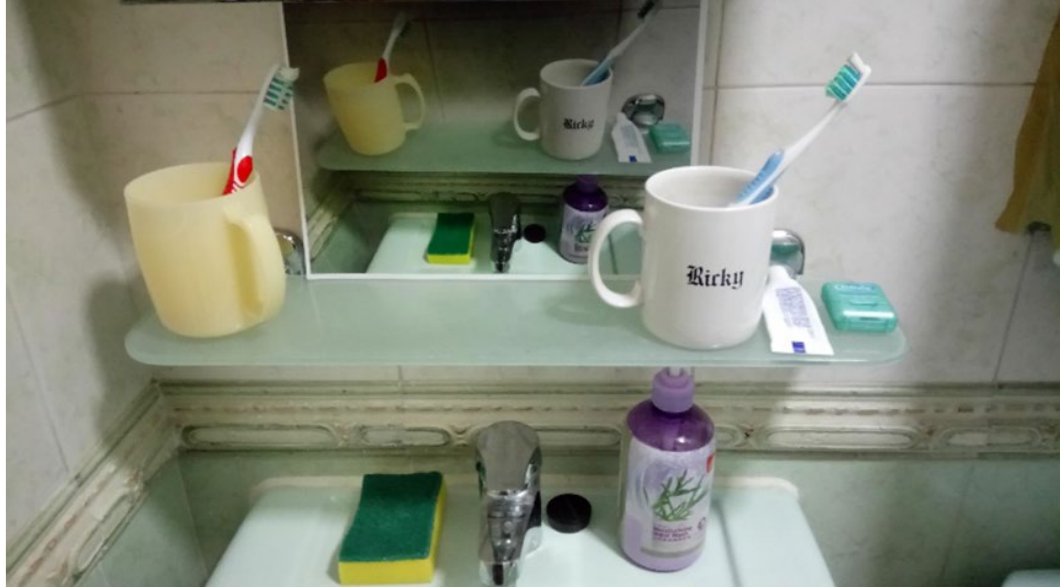
Figure 3. Using a photograph as a reminder of setting in order and shining .